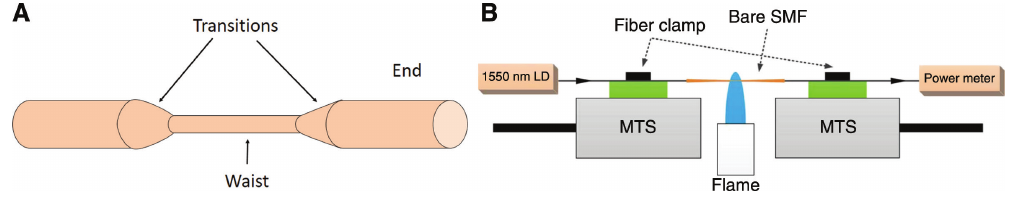
Figure 1: Structure and fabrication of a microfiber. (A) Microfiber structure. (B) Typical experimental setup for the flame-brushing scheme. Reproduced with permission [102]. Copyright 2012, IEEE Photonics